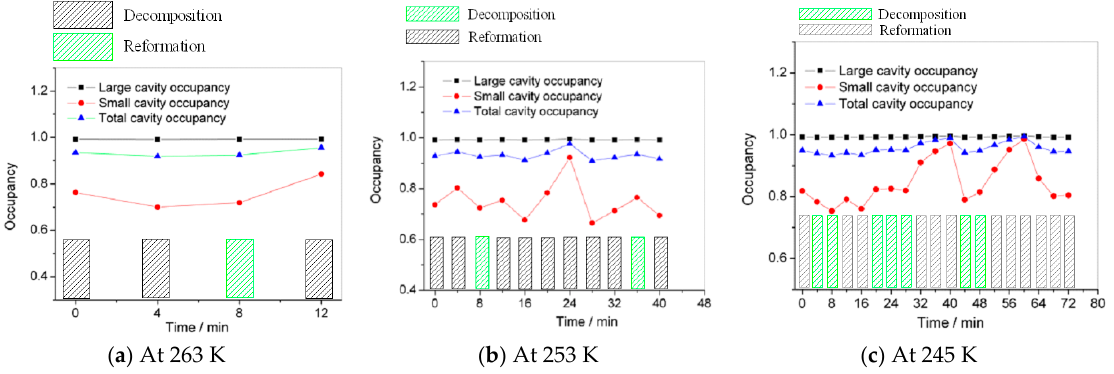
Figure 7. Methane hydrate occupancy curve.